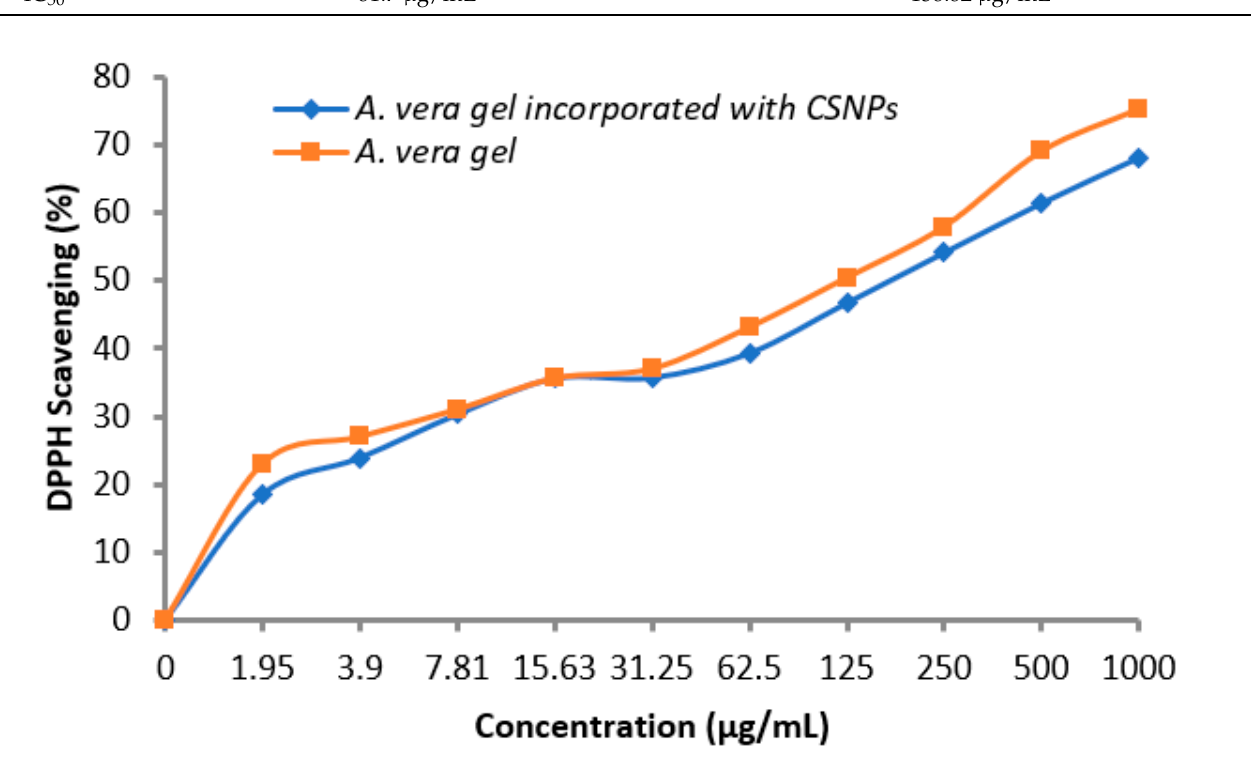
Figure 9. Antioxidant activity of A. vera gel and A. vera gel incorporated with CSNPs.